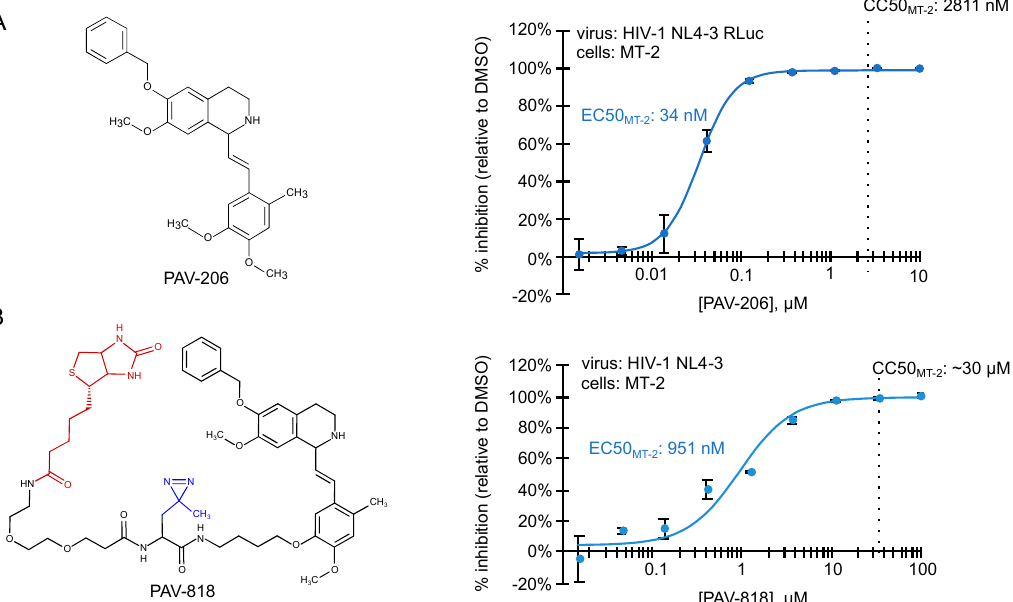
Figure 4. Small molecules that potently inhibit HIV-1 immature capsid assembly were recently described [29]. Structures of two ARV compounds are shown to the left. Dose–response curves for their inhibition of HIV-1 replication in the MT-2 T cell line are shown to the right, with EC50 and CC50 indicated. ( A ) PAV-206, is a tetrahydroisoquinolone derivative with excellent drug-like properties and a selectivity index (CC50/EC50) of ~82 in MT-2 cells. Other studies show that PAV- 206 has a selectivity index of 48 in PBMCs and inhibits virus production most likely by reducing formation of the late